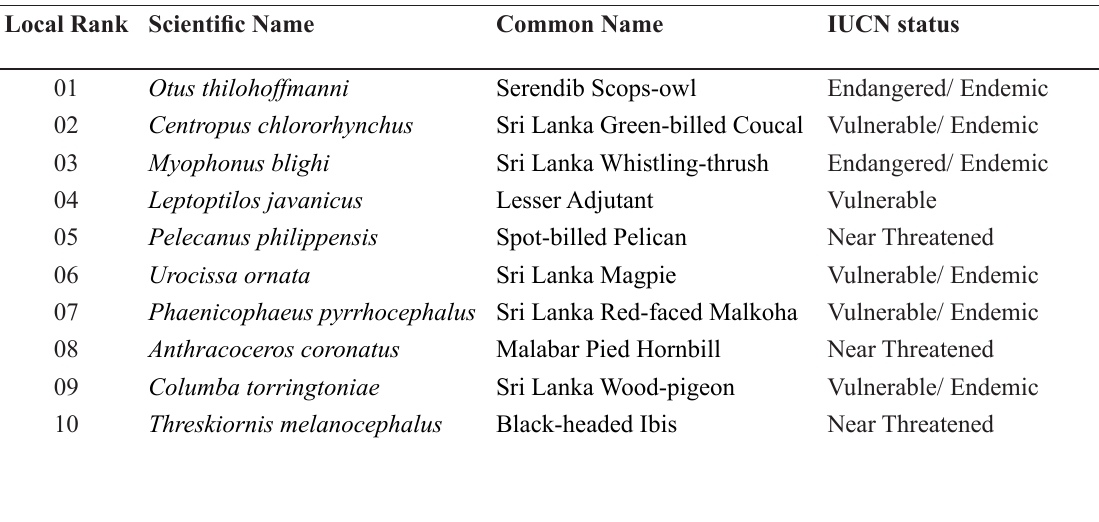
Table 02: Species that has the highest EDGE score in Sri Lanka Local Rank Scientific